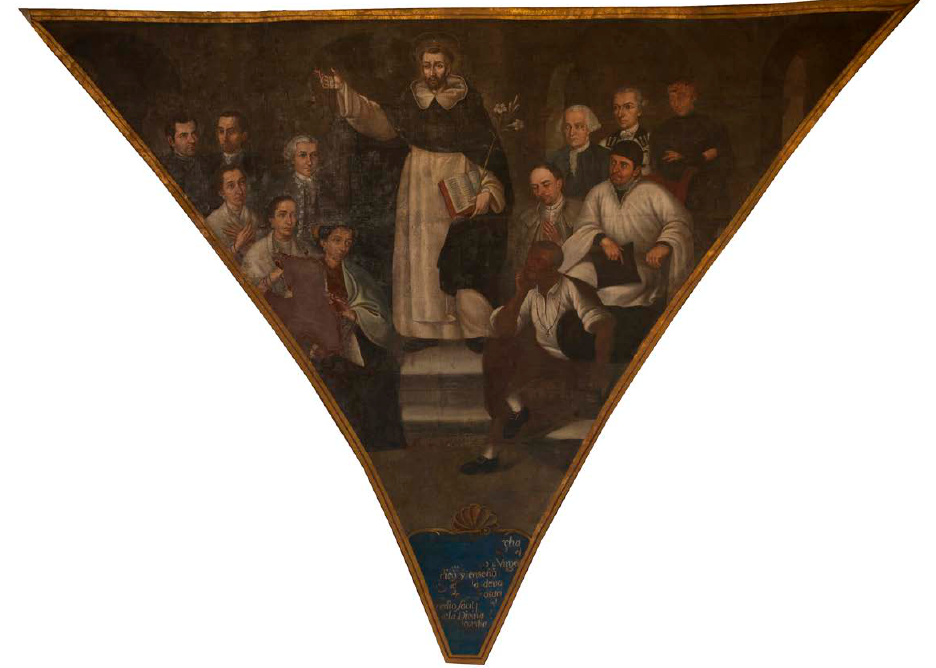
Figure 12. Jos é Nicol á s de Escalera, Familia del Conde de Casa Bayona (Family of the Count of Casa Bayona), 1770’s. Oil on canvas. Church of Santa Mar í a del Rosario, Cuba. Photo by Ramsés Hernández Batista. Courtesy of Agnes